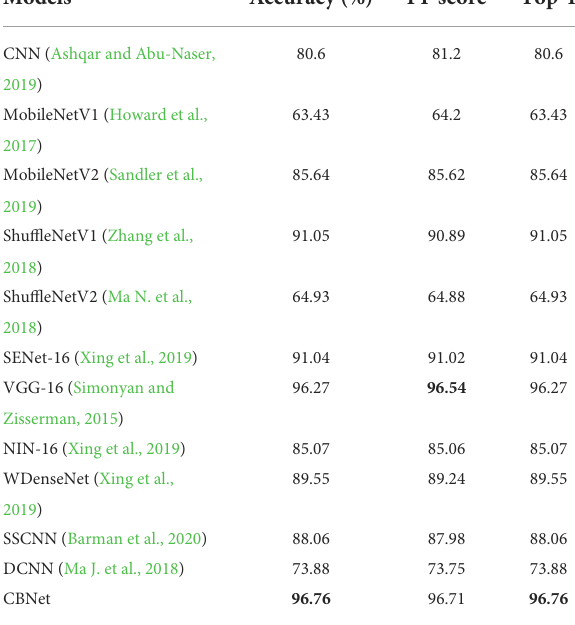
TABLE 1 Comparison of the classification results of our model and other models (bold represents the model with the best results).